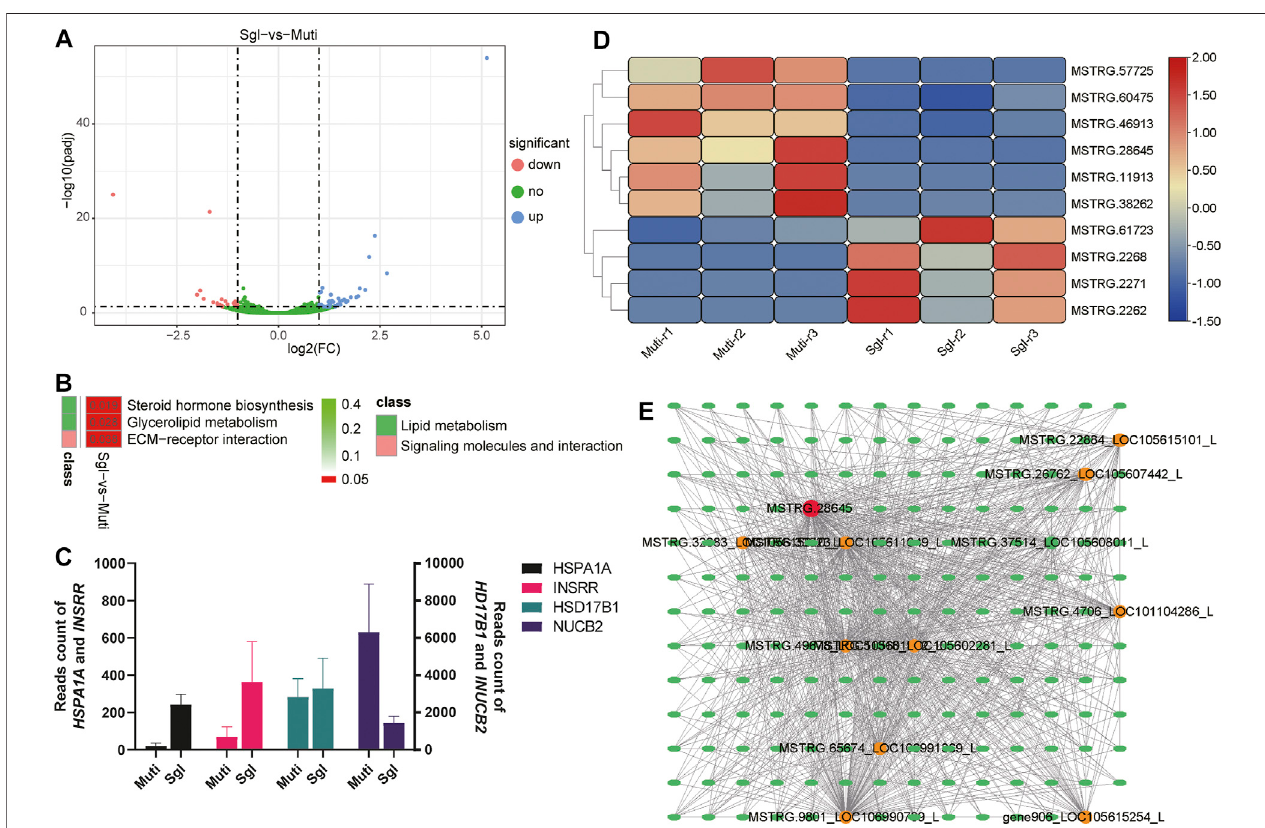
FIGURE 2 | Transcriptome analysis results. Mult, Small Tail Han sheep group, n (cid:1) 3; Sgl, Xinji fi ne wool sheep group, n (cid:1) 3; DEGs, differentially expressed genes. (A) Volcanoplotanalysisofupregulated (thebluedots)anddownregulated(themagentadots)genesbetweenMultandSgl. (B) TheKEGGenrichmentanalysisofDEGs between Mult and Sgl. The redder the cell color, the smaller the p -value, and the number on the cell is the p -value. (C) The read count number of the four genes with the largest difference in expression levels. (D) The heatmap shows the expression levels of the 10 differently expressed lncRNAs (red, high expression; blue, low expression). (E) The interaction network of mRNAs and lncRNAs. Ellipses represent mRNA, and circles represent LncRNA. The redder the color of the circle, the more mRNA connected to the lncRNA.